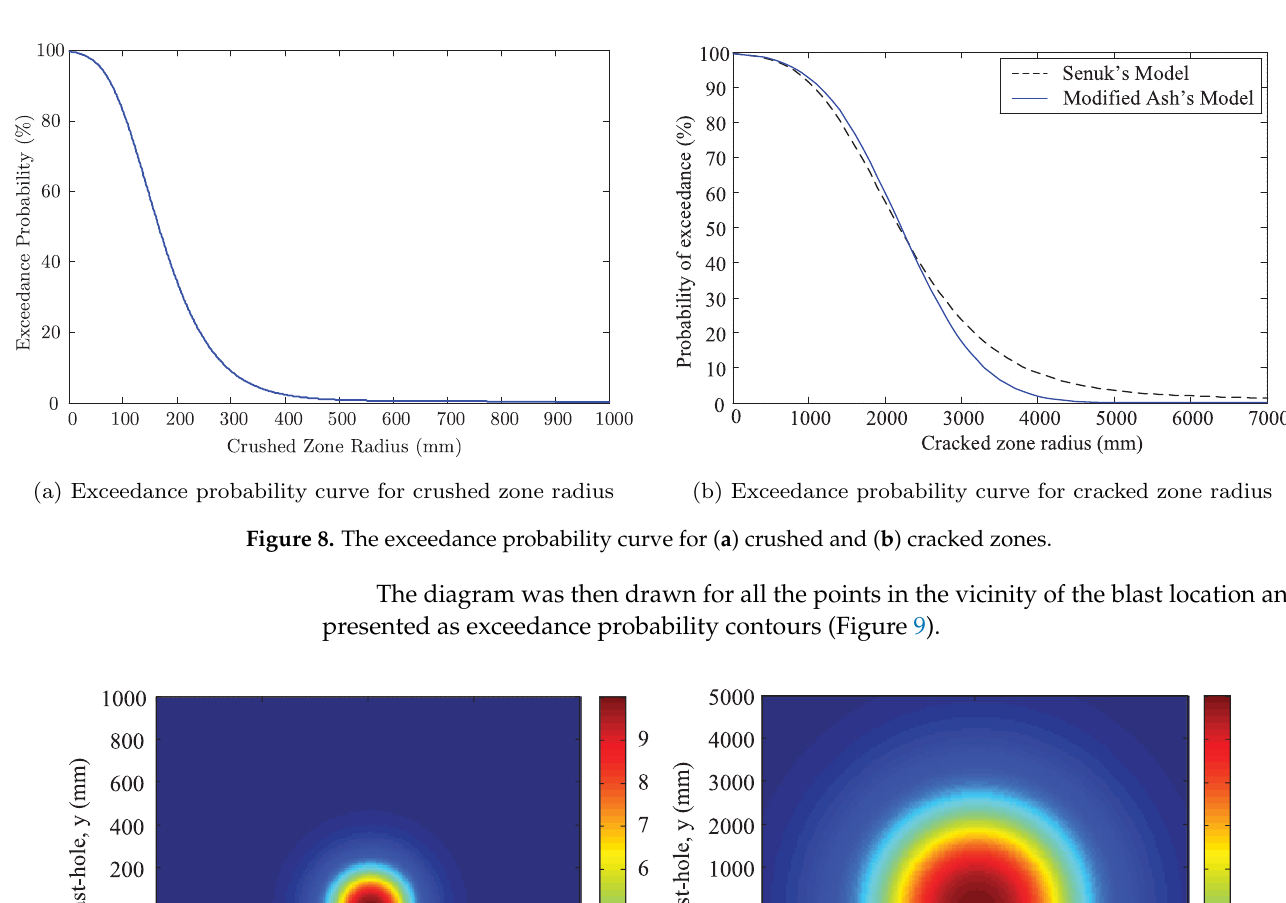
Figure 5. Exceedance probability versus (a) crushed zone radius and (b) cracked zone radius for di ff erent models.